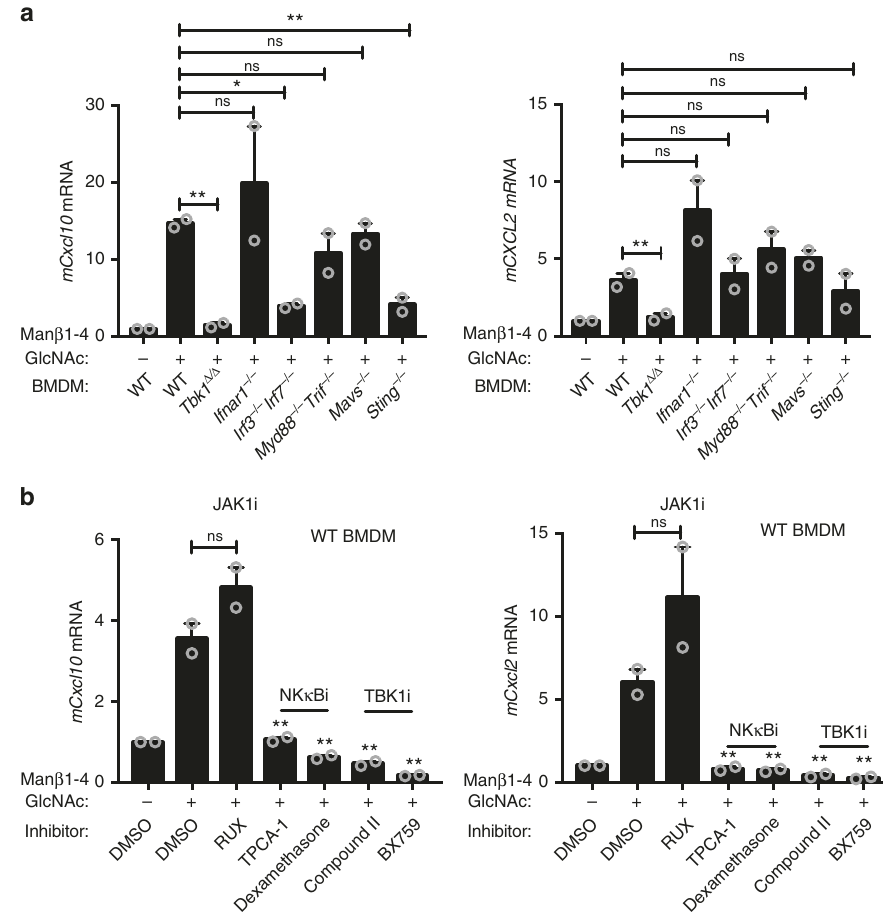
Fig. 5 The Man β 1-4GlcNAc disaccharide activates TBK1- and NF- κ B-dependent immune response. a Quantitative RT-PCR analysis of mCxcl10 and mCxcl2 mRNA in knockout BMDMs (as indicated on the bottom) that were treated with 10 μ M of the Man β 1-4GlcNAc disaccharide for 24 h. b Quantitative RT- PCR analysis of mCxcl10 and mCxcl2 mRNA in BMDMs that were pretreated with the indicated inhibitors for 1 h and then treated with 10 μ M of the Man β 1- 4GlcNAc disaccharide for 24 h. RUX, rituximab (JAK1/2 inhibitor), TPCA-1 and Dexamethasone are NF- κ B inhibitors, Compound II and BX759 are TBK1 inhibitors. See Supplementary Fig. 6 for a diagram showing innate immune pathways tested here. Data are representative of at least three independent experiments. Error bars indicate SEM. Unpaired t